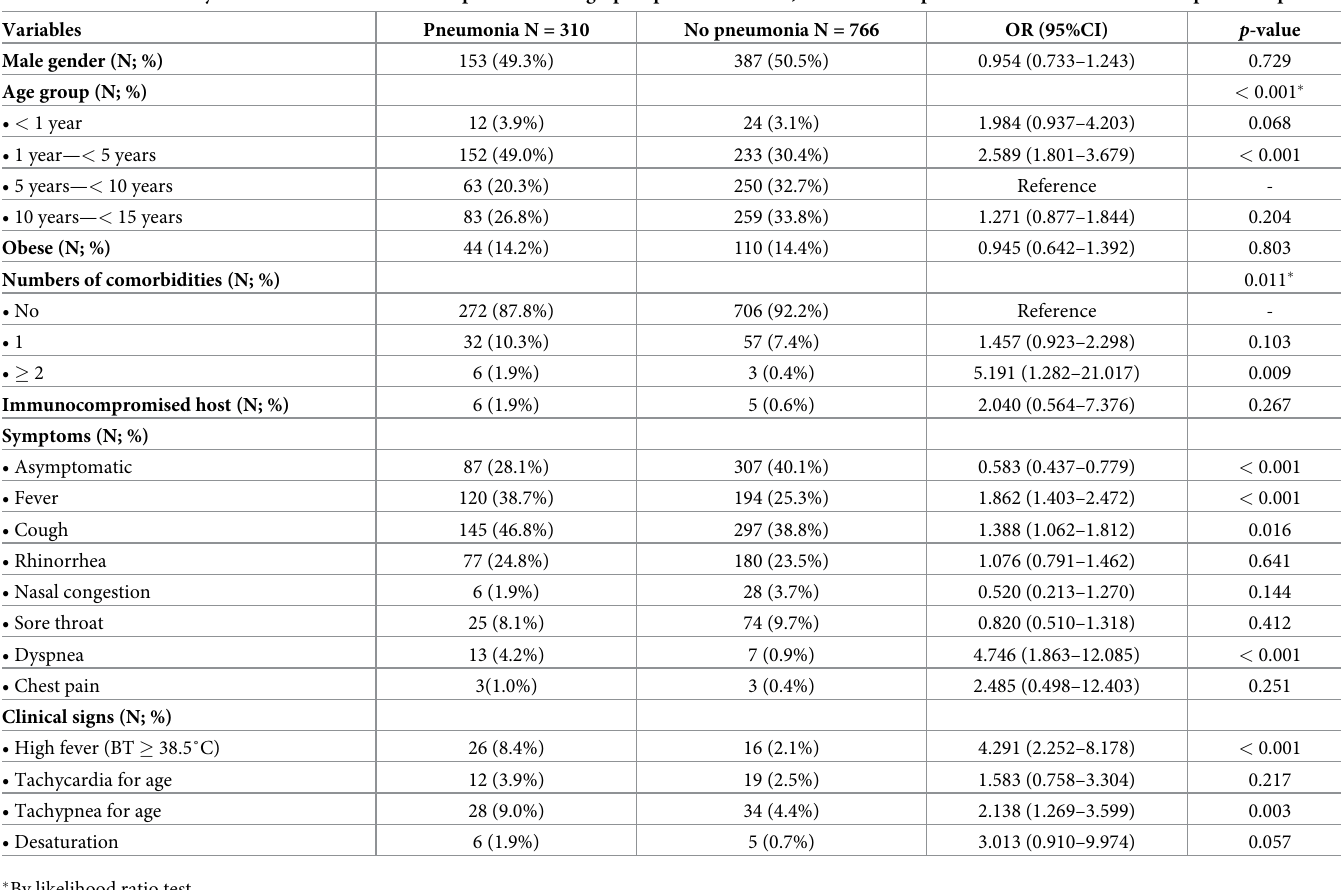
Table 2. Univariate analysis of risk factors in the development of radiographic pneumonia for 1,076 confirmed pediatric COVID-19 cases in the pre-Delta period.